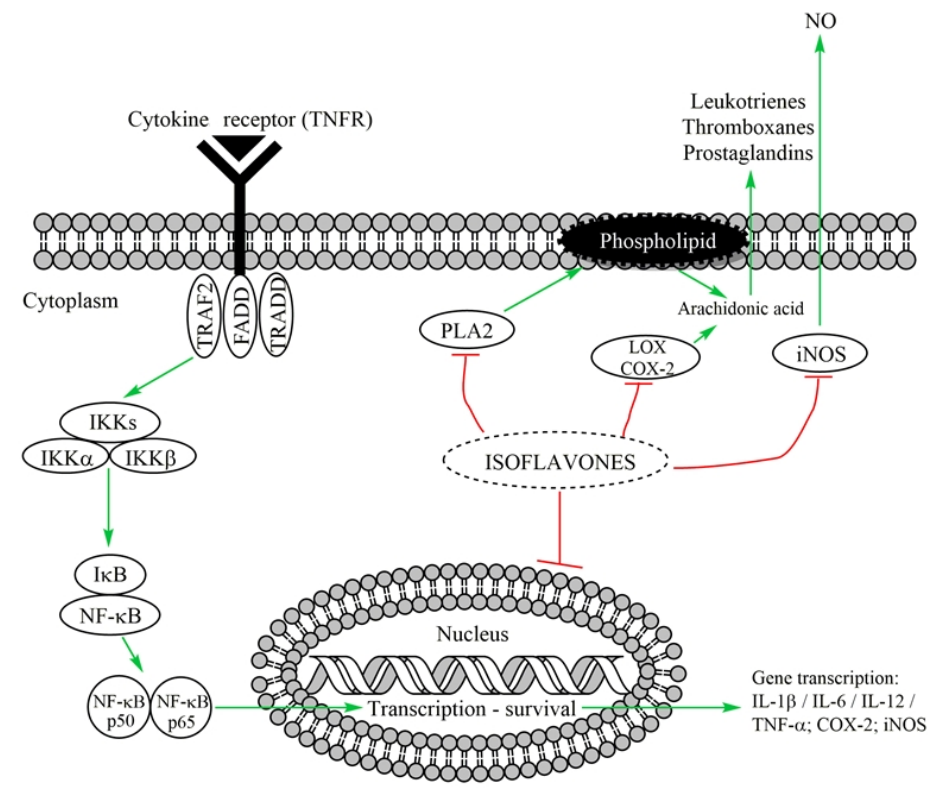
Figure 4. The effects of isoflavones in inflammation. TRAF2—tumor necrosis factor receptor asso- ciated factor-2, FADD—Fas-associated death domain protein, TRADD—TNFR1-associated death domain protein, I κ B—inhibitory factor kappa B, IKK—I κ B kinase, NF- κ B—nuclear factor of kappa light polypeptide gene enhancer in B-cells, NO—nitric oxide, PLA2—phospholipase A2, LOX— lipoxygenase, COX-2—cyclooxygenase-2, iNOS—inducible nitric oxide synthase, IL—interleukin, TNF- α —tumor necrosis factor alpha. Green arrow—activation, up-regulation; red arrow—blocking, down-regulation.